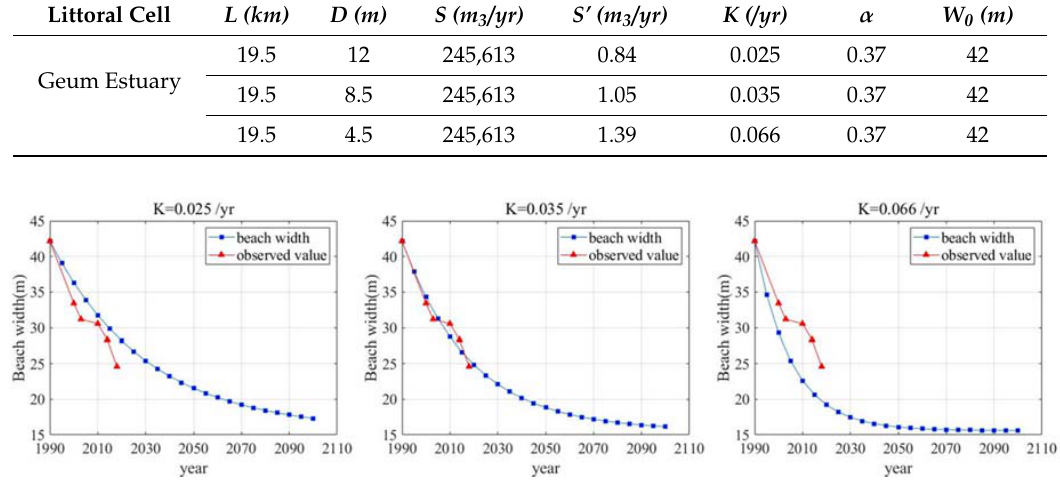
Table 8. Parameters of beach width calculation formula from coastal sediment loss rate ( K ).